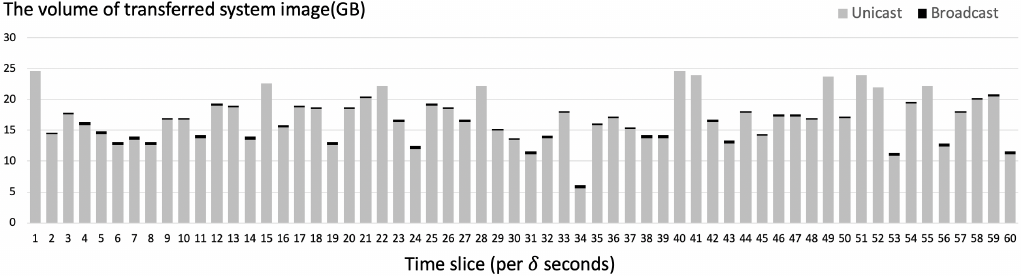
Figure 17. The amount of usage of broadcast and unicast per time slice ( δ seconds) simulated on the